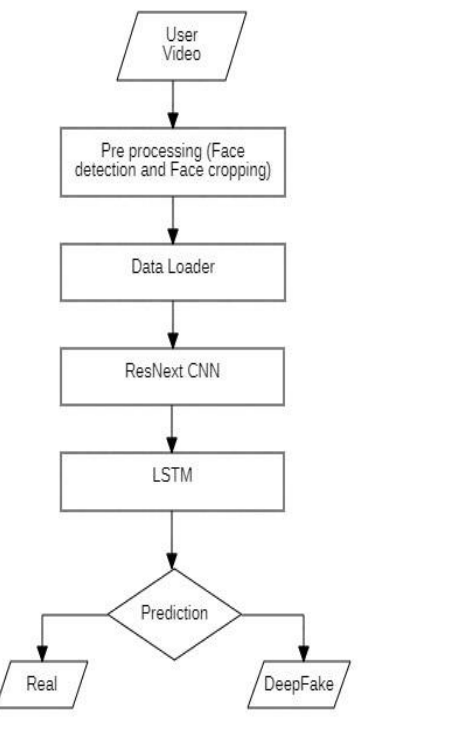
Fig. 10. Prediction Flow